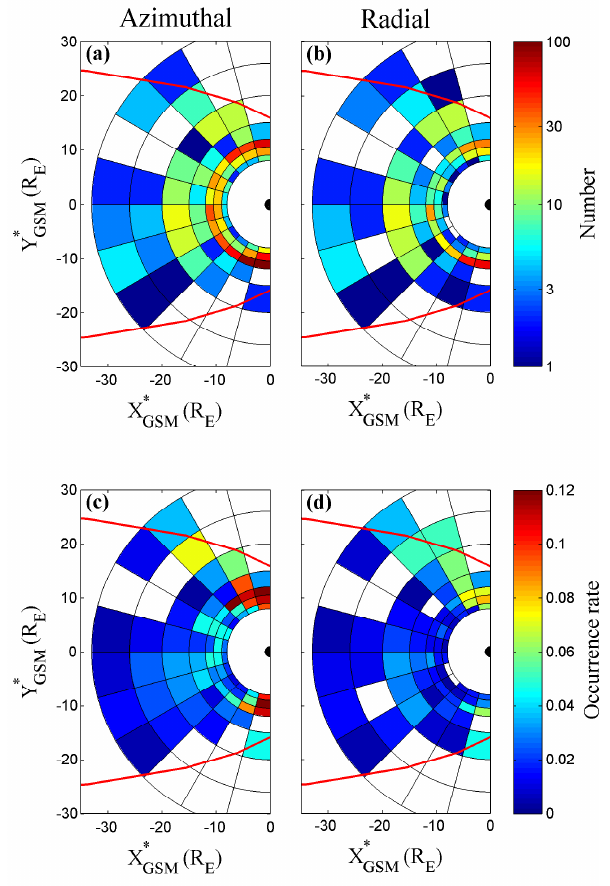
Figure 3. The number (a, b) and occurrence rates (c, d) of azimuthal oscillating wave events (a, c) and radial oscillating wave events (b, d) in the GSM ∗ X - Y plane.